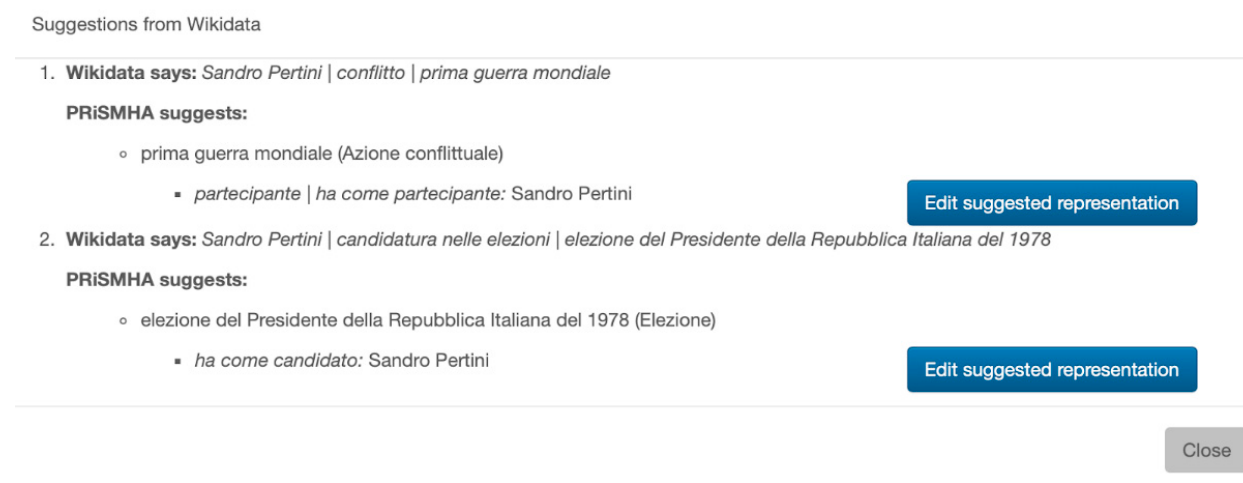
Figure 13. Event suggestions for Sandro Pertini, obtained from Wikidata.